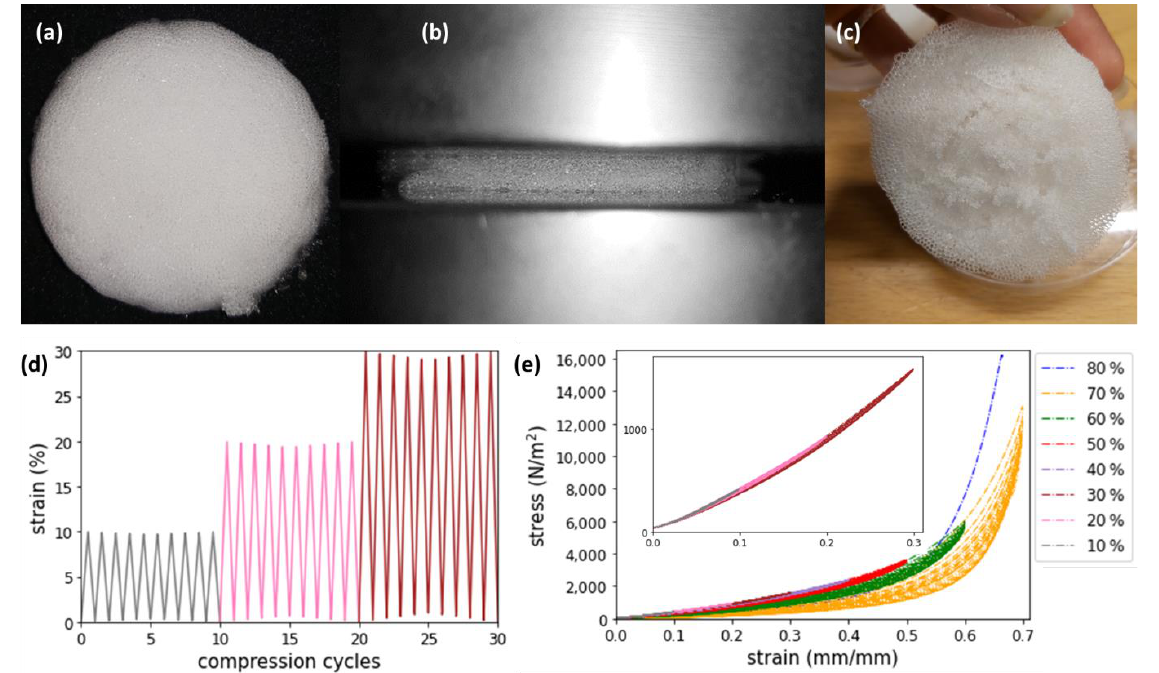
Figure 5. Compression behavior of printed foams samples. ( a ) Cylindrical samples with a diameter of 60 ± 1 mm and thickness of 14 ± 1 mm are used for compression testing. ( b ) Sample under 70% compression in the testing machine. ( c ) Sample after compressing to 80%, showing loss of integrity. ( d ) Loading as measured during cyclic mechanical testing. Compression cycles are shown for the strain values of 10%, 20%, 30%. The colors are indicated in the legend of ( e ). ( e ) Stress – strain curves for the compressive loading up to 80% strain. The average measurement of 3 samples is shown. Hysteresis is almost negligible up to 40% strain (the inset details the strain curves between 10% and 30%).